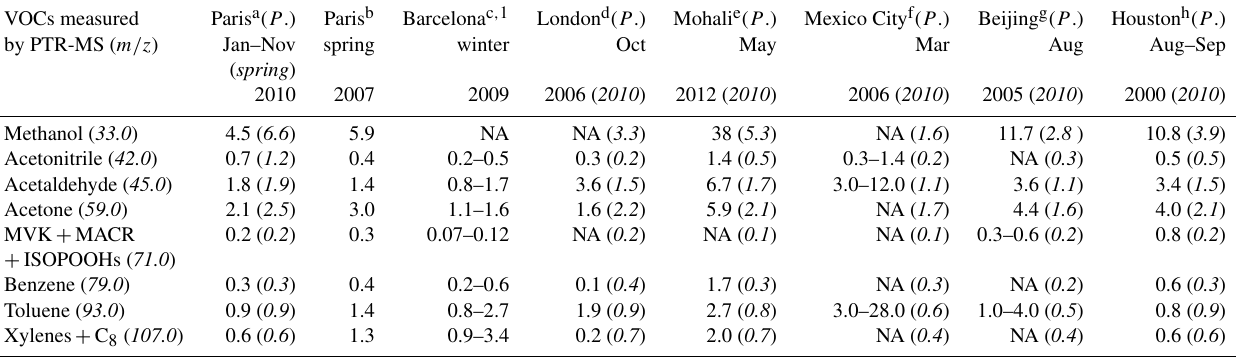
Table 2. Comparison of mean concentrations of selected VOCs (measured by PTR-MS) with ambient levels observed in the literature from different urban atmospheres. All average values are reported in parts per billion.